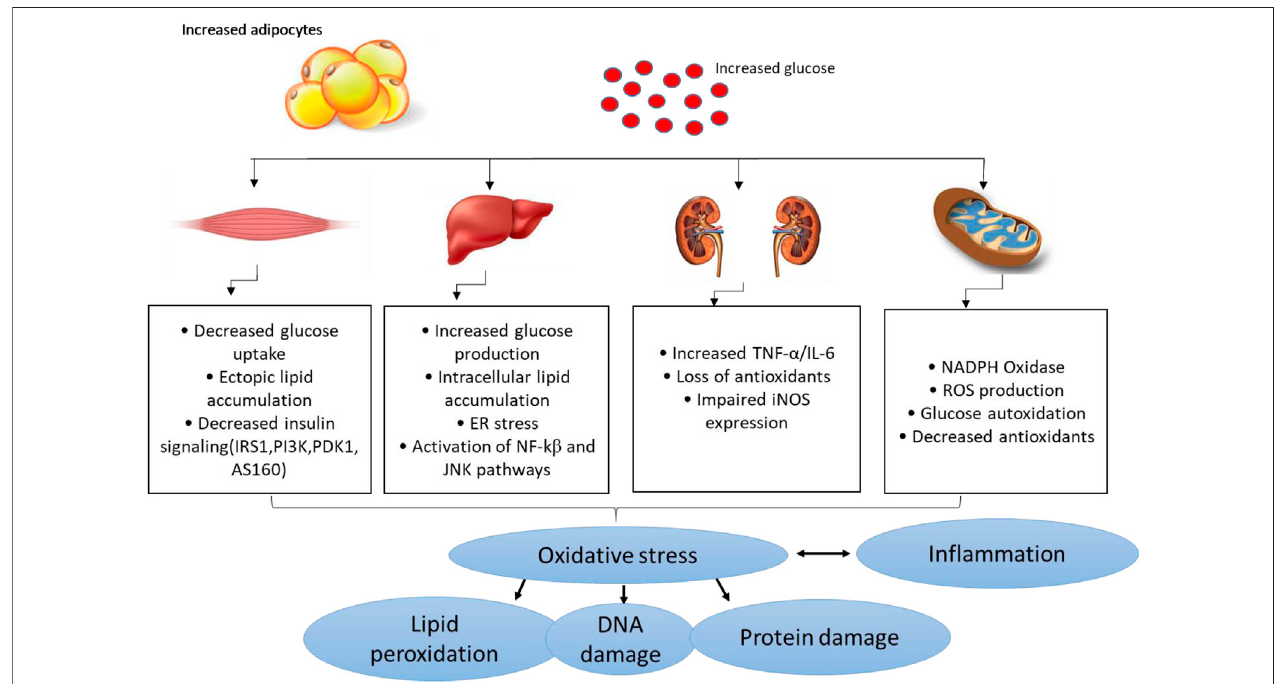
FIGURE 2 | An overview of pathological mechanisms implicated in the development of diabetes mellitus or related metabolic complications. Brie fl y, overnutrition (which may be characterized by increased adipocyte size) and consistent increased levels of glucose (a state of hyperglycemia) may induce detrimental effects in major organs of the body including the skeletal muscle, liver, and kidneys, and thus aggravate metabolic complications through enhanced oxidative stress and exacerbated in fl ammation. This consequence is predominantly characterized by impaired glucose homeostasis/insulin signaling, ectopic lipid accumulation, mitochondrial dysfunction,endoplasmicreticulum(ER)stressinsuf fi cientordecreasedantioxidantresponses/increasedROS(reactiveoxygenspecies)productionandalteredactions ofinduciblenitricoxidesynthase(iNOS)andlipidperoxidation/DNAdamage.Thismayoccuralongwithraisedpro-in fl ammatorymarkersliketumornecrosisfactor-alpha (TNF- α ), like nuclear factor kappa β (NF- κβ ), c-Jun N-terminal kinases (JNK) and interleukin-6